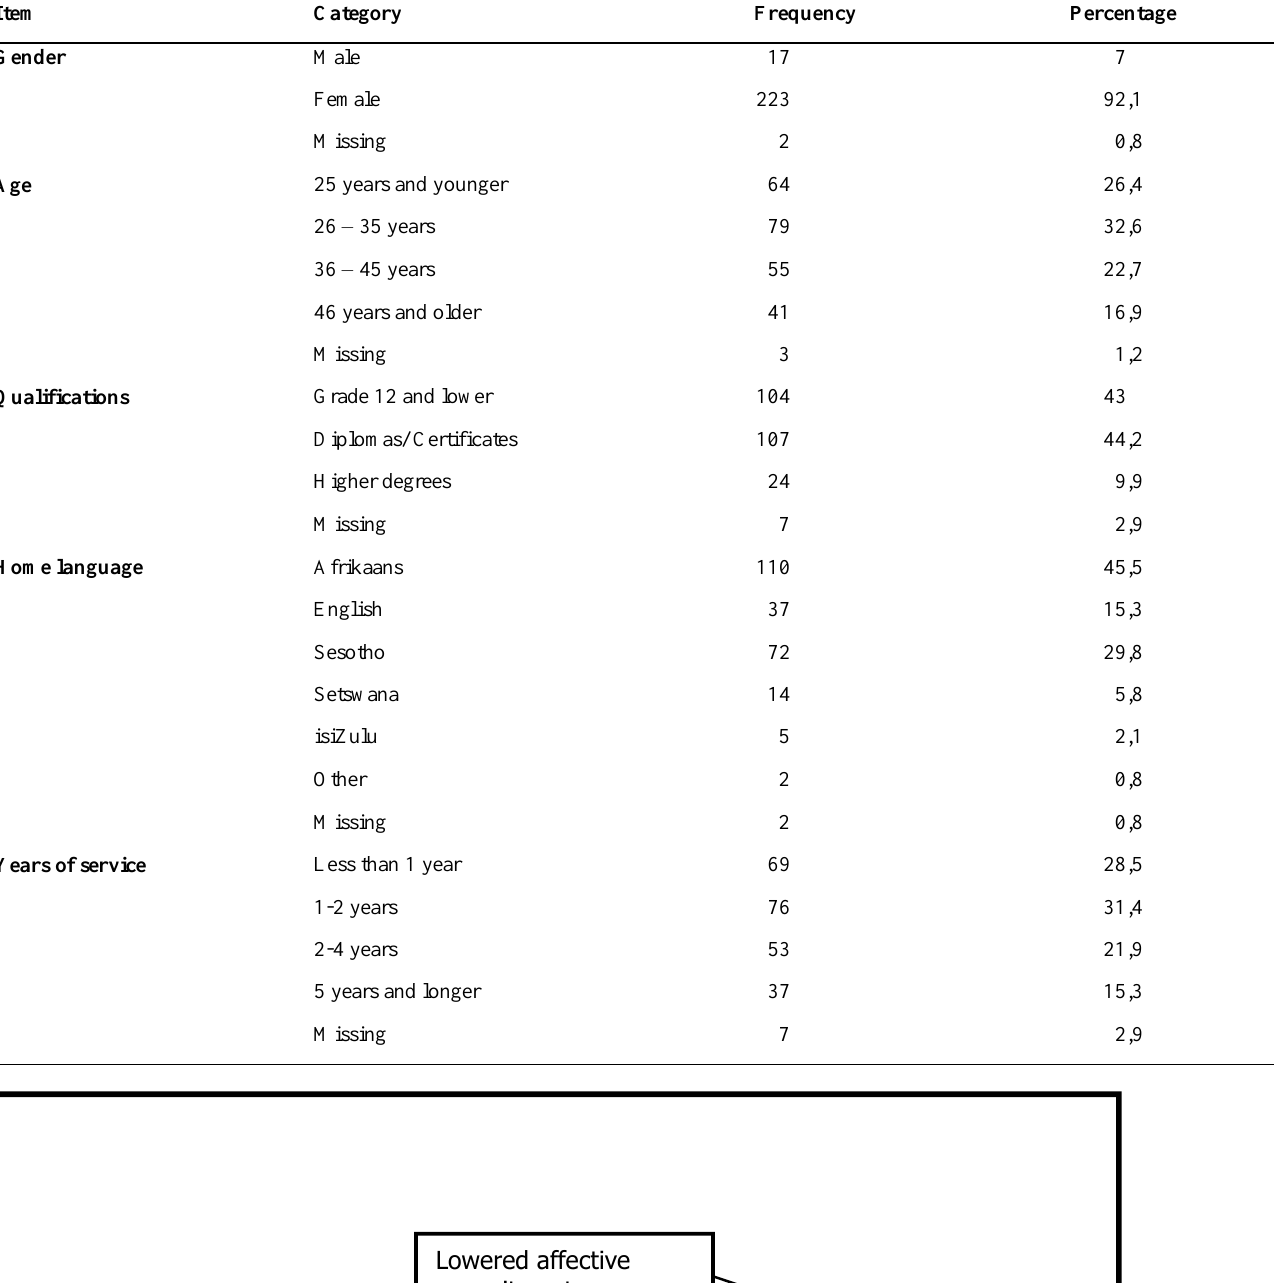
Increased perceptions of